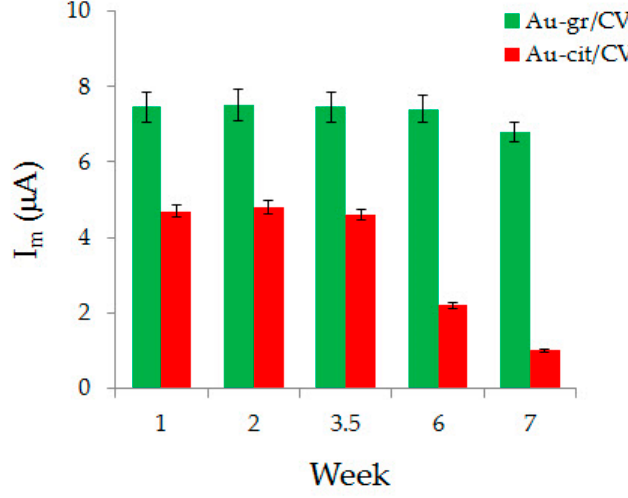
Figure 9. Stability of AA response on Au-gr / CVE and Au-cit / CVE.